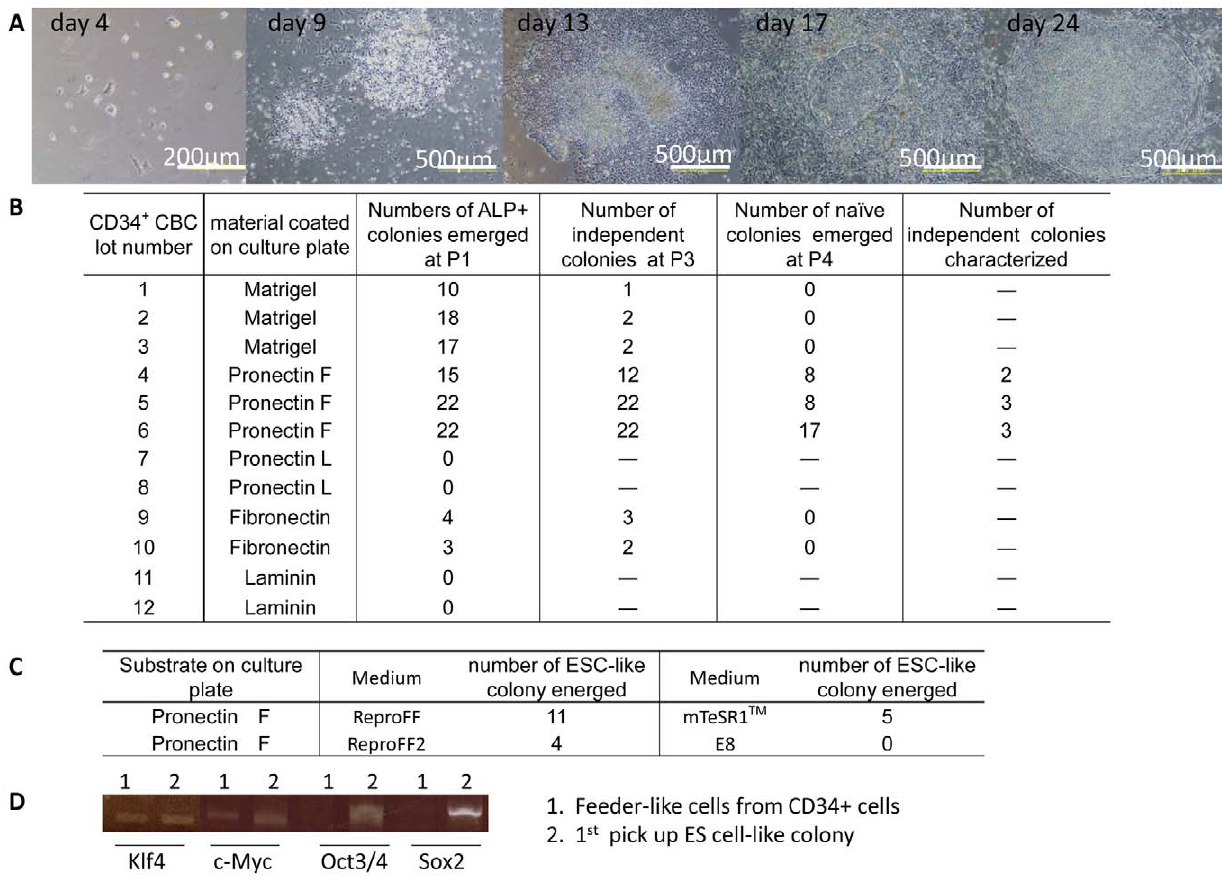
Figure 2. The process of reprogramming and recloning. (A) Phase contrast light microscopic observation of cells during reprogramming and recloning. Images captured on a Pronectin F-coated dish prior to colony picking on days four, nine, 13, 17 and 24 (upper panels). Note that human ES cell-like colonies emerged within a cobblestone like morphology. (B) Efficiency of generating reprogrammed cells on various coating materials and the number of colonies characterized. All the experiments used 1 6 10 4 CD34 + CBCs, SeV TS vectors at 20 M.O.I. and ReproFF medium. Three independent experiments for Matrigel, Pronectin F and two independent experiments for fibronectin and laminin (Laminin-extracts), Pro nectin L we re performed. (C) Frequency of generating human ES cell-like colonies in various culture media. Five thousand CD34 + CBCs were infected with 20 M.O.I. of SeV carrying four factors and cultured in ReproFF, ReproFF2, mTeSR1, or E8 medium on Pronectin F-coated dishes to reprogram CD34 + CBCs. D: Endogenous gene expression of Klf4, c-Myc, Oct3/4, and Sox2 in feeder like-cells (lane 1) and first pick up of a human ES cell like-colony (lane